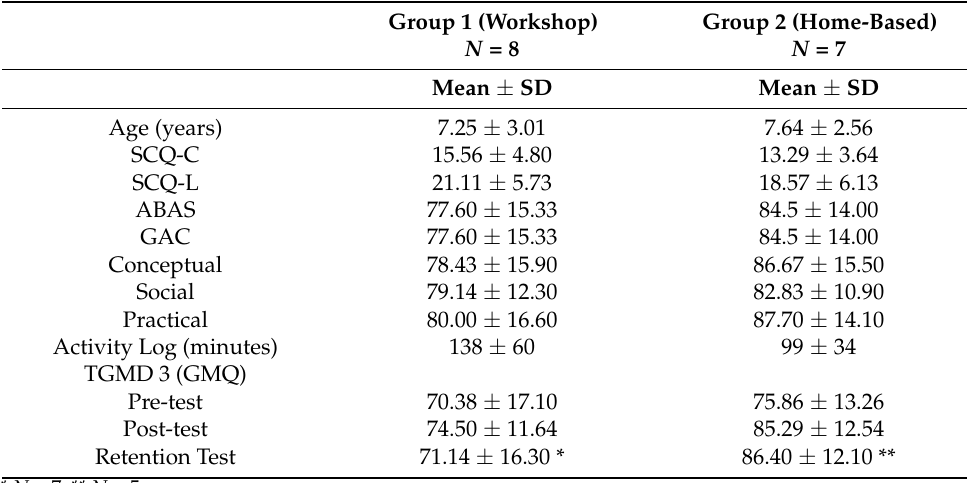
Figure 1. Consort Reporting of Trails Diagram. Table 1. Descriptive Statistics for Sample and TGMD-3 Across Intervention.